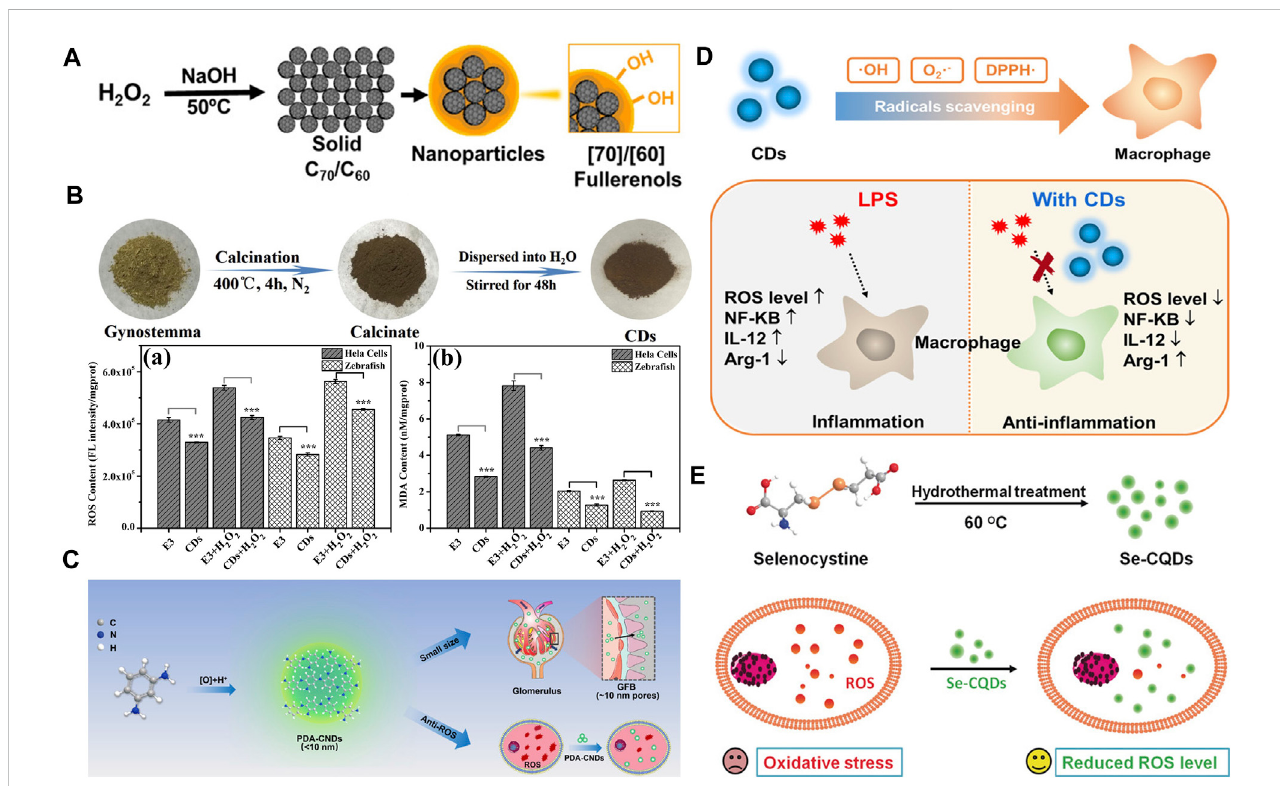
FIGURE 1 (A) Preparation of C 70 -OH and C 60 -OH nanoparticles against oxidative injury (Zhou et al., 2017). antioxidant against H 2 O 2 -induced oxidative in both Hela cells and zebra fi sh (Wei et al., 2019). (C) Phenylenediamine-based carbon nanodots were used to eliminate ROS in acute kidney injury (Gao et al., 2020). (D) Carbon dots made of citric acid and glutathione serve as a highly ef fi cient intracellular